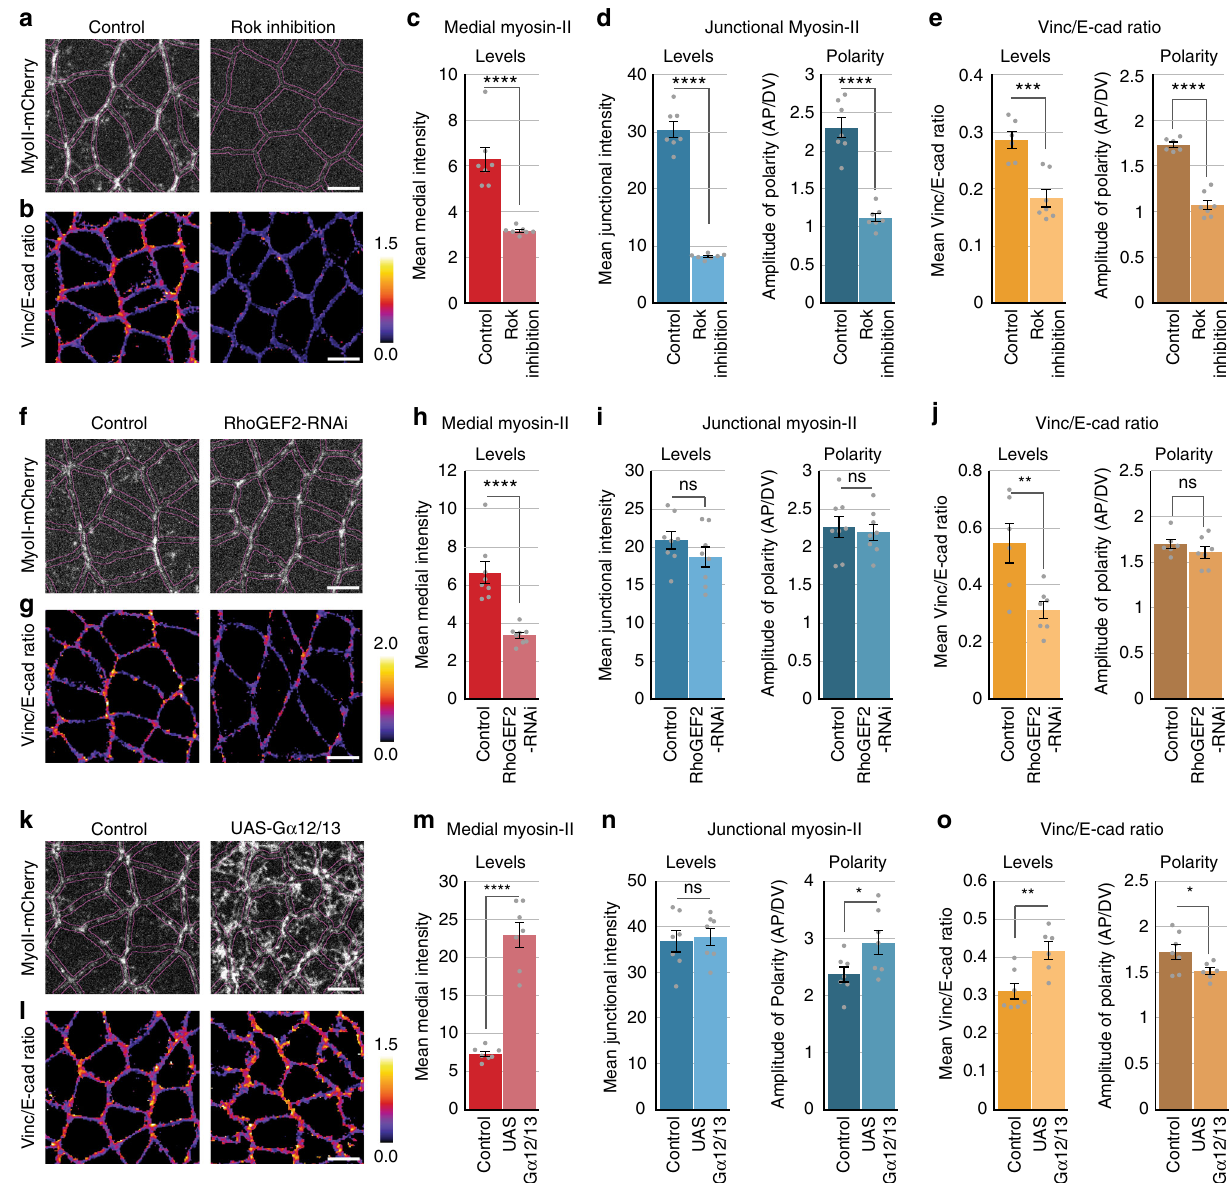
Fig. 4 Medial and junctional Myosin-II distinctly tunes Vinc/E-cad ratio distribution. Representative images showing the distribution of Myosin-II ( a ) and Vinc/E-cad ratio ( b ), in the water injection “ control ” embryos (left) and H1152-injected “ Rok inhibition ” embryos (right). c , d Quanti fi cations showing the levels of Myosin-II in medial and junction pool, along with planar polarity. Data from n = 7 embryos for both controls and Rok inhibitions. e Quanti fi cations showing the mean junctional Vinc/E-cad ratio, along with planar polarity. Data from n = 6 embryos for controls and n = 7 for Rok inhibitions. Representative images showing the distribution of Myosin-II ( f ) and Vinc/E-cad ratio ( g ), in the control embryos (left) and RhoGEF2-RNAi embryos (right). h , i Quanti fi cations showing the levels of Myosin-II in medial and junctional pool, along with planar polarity. Data from n = 8 embryos for both RhoGEF2-RNAi and control. j Quanti fi cations showing the mean junctional Vinc/E-cad ratio along with planar polarity. Data from n = 6 embryos for control and n = 7 embryos for RhoGEF2-RNAi. Representative images showing the distribution of Myosin-II ( k ) and Vinc/E-cad ratio ( l ), in the control embryos (left) and G α 12/13 over-expressing embryos (right). m , n Quanti fi cations showing the levels of Myosin-II in medial and junctional pool along with planar polarity. Data from n = 7 embryos for both G α 12/13 over-expression and control. o Quanti fi cations showing the mean junctional Vinc/E-cad ratio along with planar polarity. Data from n = 7 embryos for control and n = 6 embryos for G α 12/13 over-expression. All scale bars represent 5 μ m. All error bars represent SEM. Statistical signi fi cance estimated using two-tailed Student ’ s t -test. Images/quanti fi cations in a , c , d , f , h , i , k , and m , n come from embryo co-expressing MyoII-mCherry and E-cadherin-GFP, while those in b , e , g , j , l , and o come from embryo co-expressing Vinculin-mCherry and E-cadherin- GFP. The proportion of tagged vs untagged protein pool varies across different experiments (see Methods: Fly lines and genetics). In all cases, Junctions marked based on E-cadherin localization. Images/quanti fi cations in b and e are from the same set of embryos as those presented in Figure 1o – q. ns, p > 0.05; *, p < 0.05; **, p < 0.01; ***, p < 0.001; ****, p <